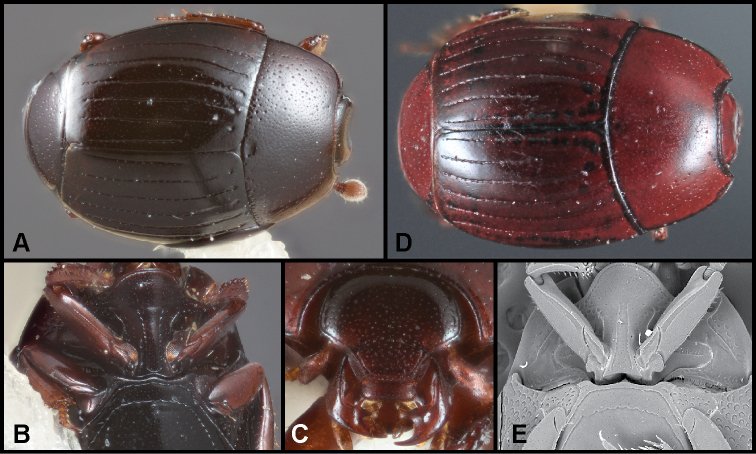
A–CPhelisterparallelisternus Schmidt: A Dorsal habitus B Ventral view showing prosternal and meso- and metaventral striae C–EPhelistermobilensis Casey: C Frontal view showing complete epistomal stria D Dorsal habitus E Ventral view (SEM) showing prosternal and meso- and metaventral striae.